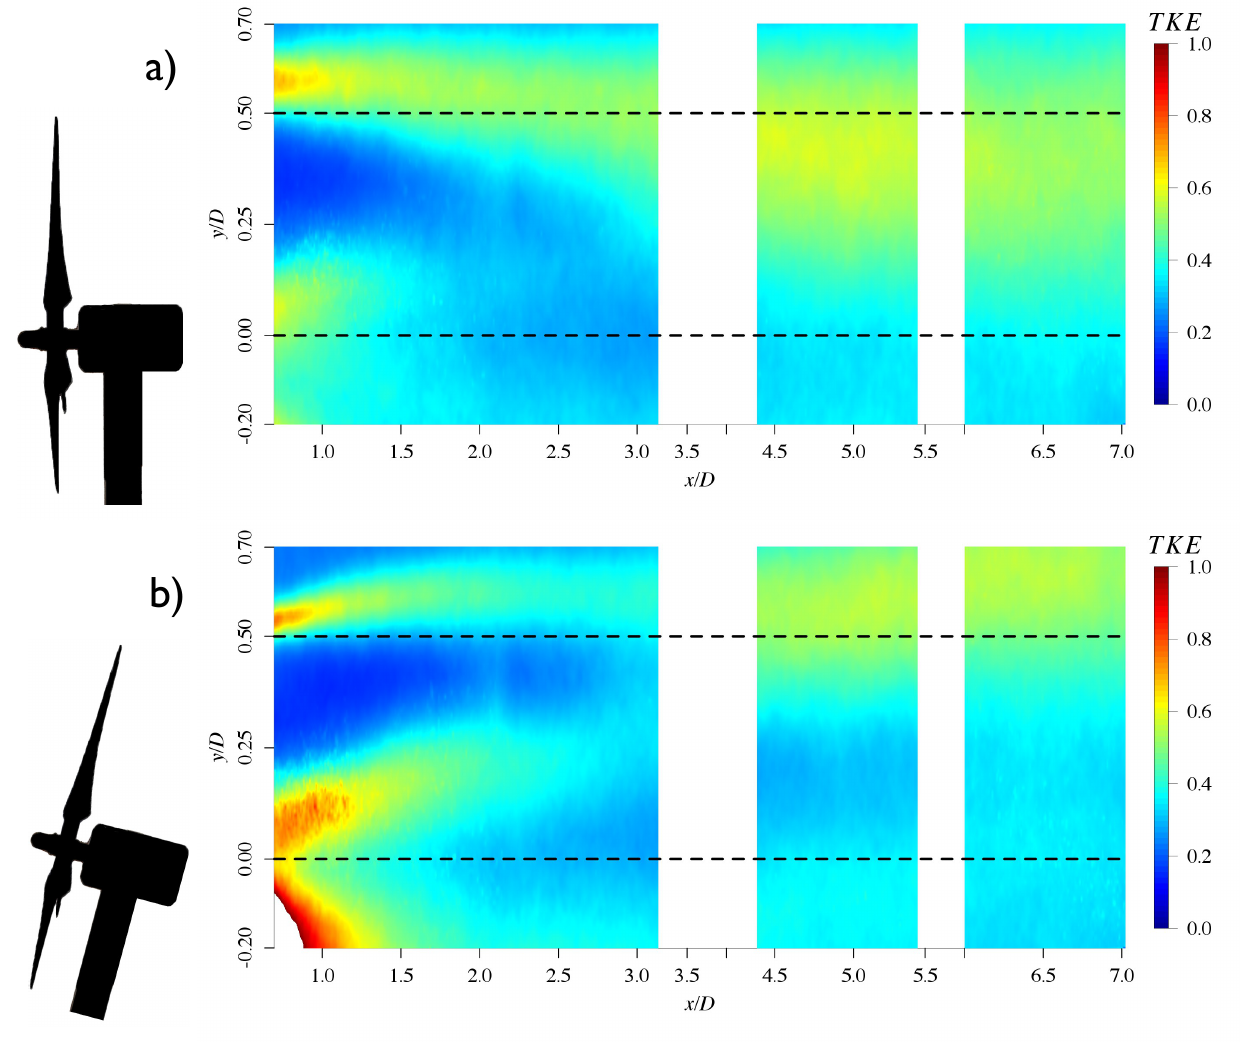
( uu + vv + ww ) for ( a ) fixed and 2 . Hub height ( y/D = 0) and top blade hh